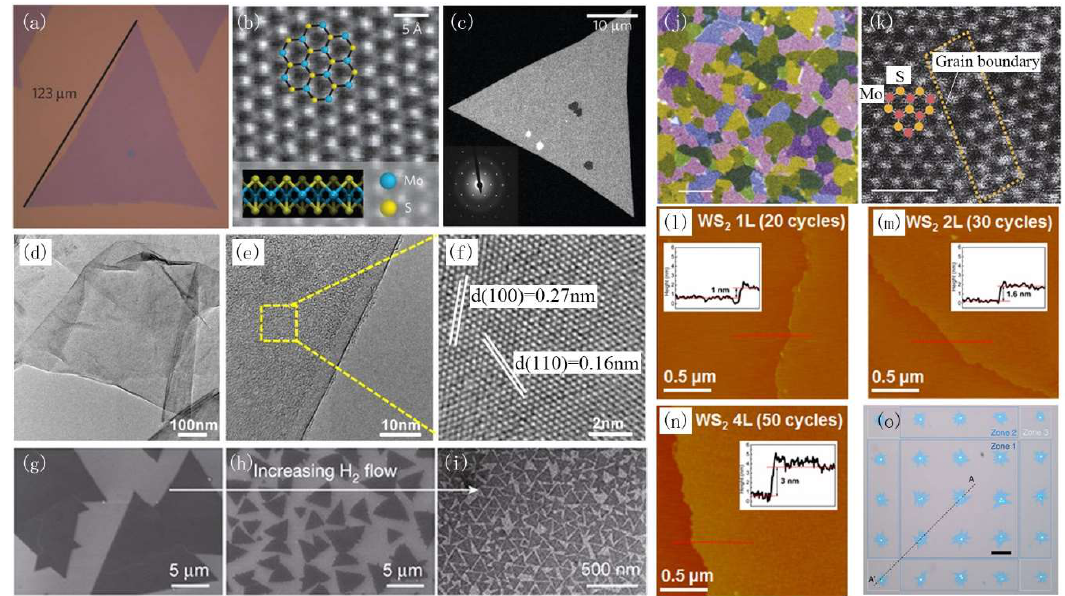
Figure 3. Chemical synthesis of TMDC films. ( a ) Optical image; ( b ) high-resolution scanning transmission electron microscope (STEM) image and ( c ) dark-field transmission electron microscope (DF-TEM) image of CVD-grown monolayer MoS 2 on SiO 2 /Si substrate [64]; ( d – f ) Bright field transmission electron microscope (TEM) and high resolution transmission microscope (HR-TEM) image of MoS 2 with 600 nm grain size grown with MoO 3 and sulfur powder as solid phase precursor [65]; ( g – i ) Scanning electron microscope (SEM) image and TEM image of grain size variation due to the influence of hydrogen flow rate based on the metal-organic chemical vapor deposition (MOCVD) method [66]; ( j ) False color DF-TEM image and ( k ) Angular dark field scanning transmission electron microscope (ADF-STEM) image of continuous MoS 2 monolayer film grown by MOCVD [66]; ( l – n ) AFM image of WS 2 film with different thickness controlled by atomic layer deposition (ALD) cycles [70]; ( o ) Monolayer MoS 2 grown at specific location with seeding layer